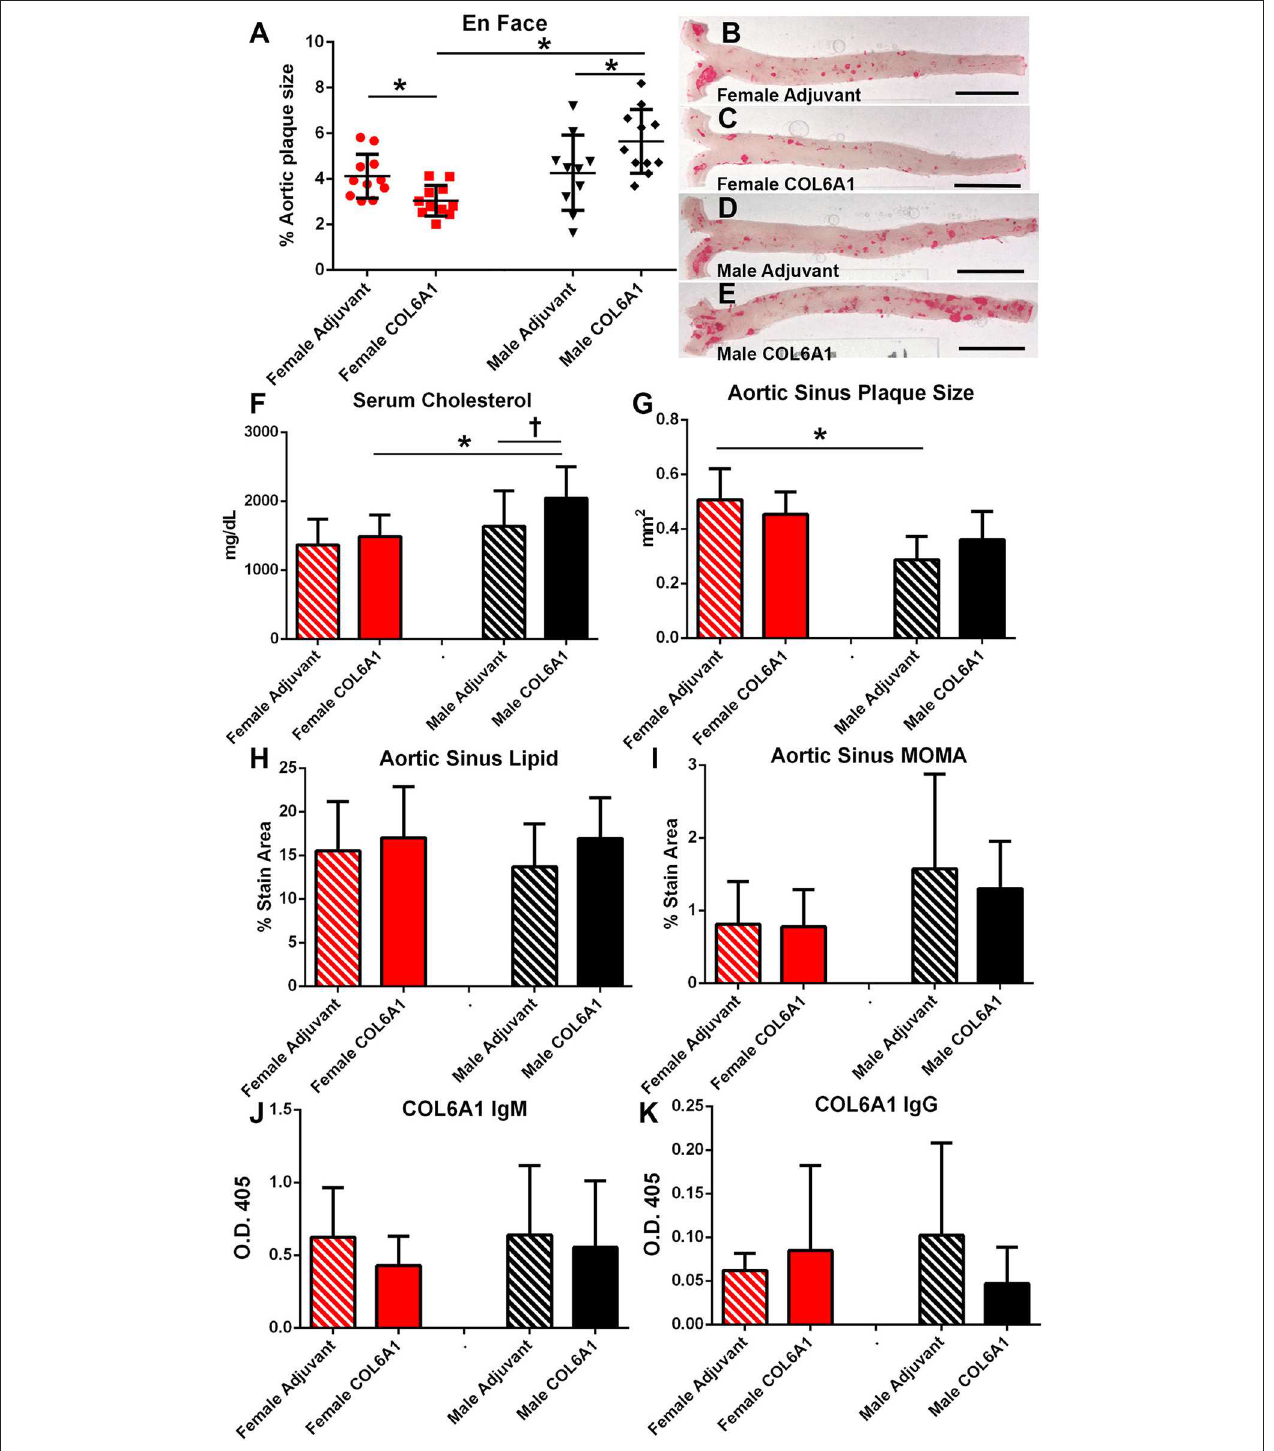
FIGURE 7 | Sex as determinant of outcome in COL6A1 immunized apoE–/– mice. Female and male apoE–/– mice were immunized with the mouse homolog of collagen 6A1 (COL6A1) and effect on atherosclerosis was measured on en face Oil Red-O staining of the aorta (A) . * P < 0.05 by ANOVA and Holm–Sidak’s post–test. Representative photographs of en face Oil Red-O preparation of aortas from female mice injected with Adjuvant alone (B) or COL6A1 peptide (C) and male mice injected with Adjuvant alone (D) or COL6A1 (E) . Bar = 0.5cm. Female mice N = 11 each; Male Adjuvant N = 10, Male COL6A1 N = 11. Serum cholesterol (F) , aortic sinus plaque size (G) , aortic sinus lipid as stained with Oil Red-O (H) , and sinus plaque macrophage presence as stained with MOMA-2 (I) in mice immunized with COL6A1. Anti-COL6A1 IgM levels (J) and anti-COL6A1 IgG levels (K) . * P < 0.05; † P = 0.065; N = 7–11 per group.